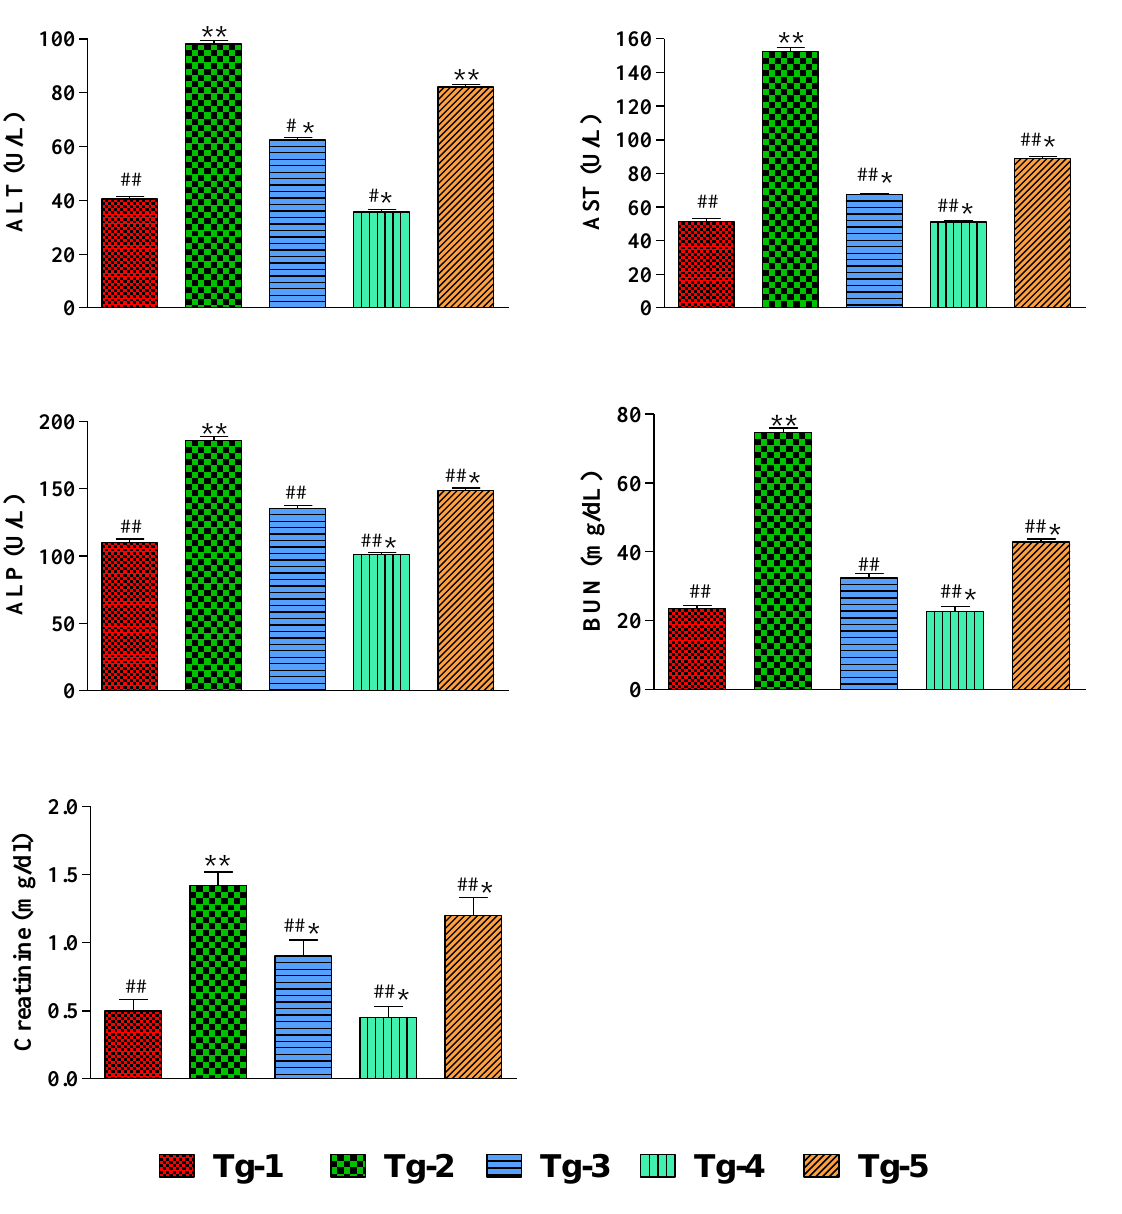
Figure 3. Effect of compound 3 on serum markers ALT, AST, ALP, BUN, and creatinine level in diabetic mice. The results are presented as mean ± SEM ( n = 3), ** p < 0.01, and * p < 0.05; vs. control group, # p < 0.05; ## p < 0.01 vs. STZ group. Aspartate transaminase (AST), alanine